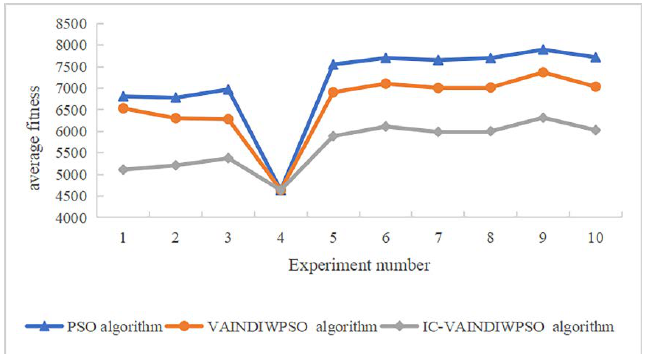
Figure 18. The average value of fitness functions for different environments.